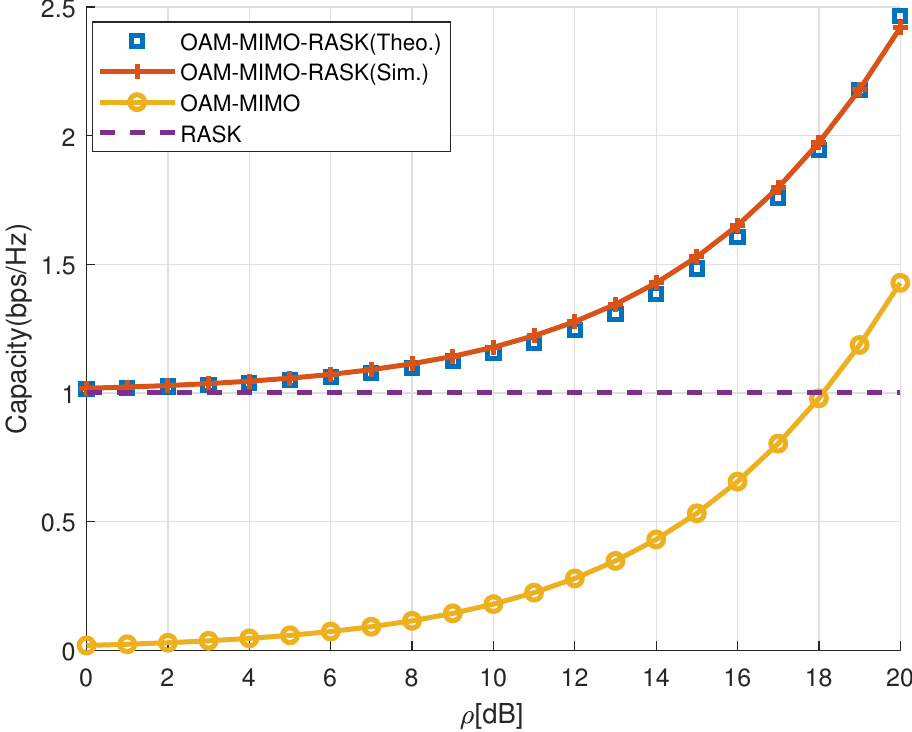
Figure 2. SC comparison between OAM-MIMO-RASK, OAM-MIMO, and RASK with respect to transmit SNR ( ρ